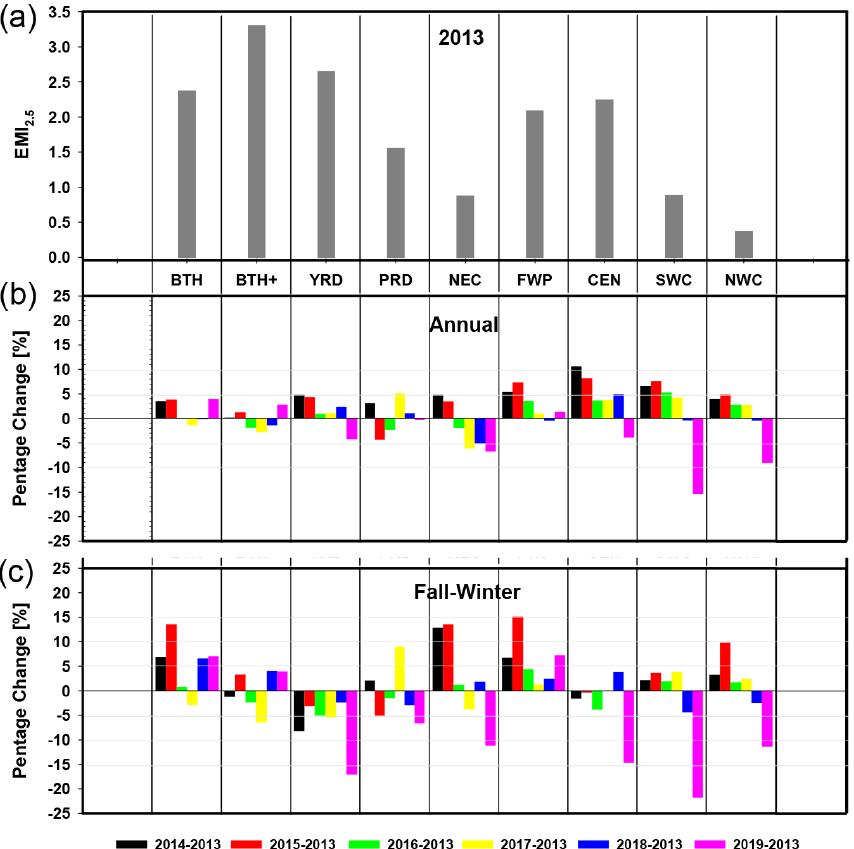
Figure 9. Annual averaged EMI 2 . 5 in 2013 (a) and corresponding changing rates for the annual average (b) and for the fall–winter seasons (c) from 2014 to 2019 as compared with 2013 in nine regions.